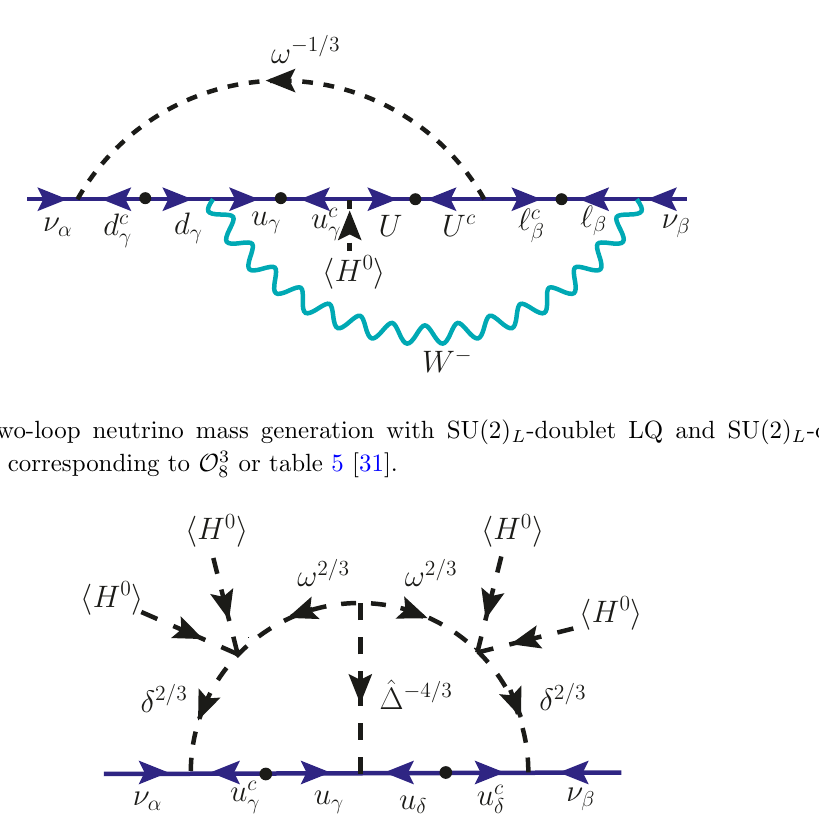
Figure 51 . New two-loop scalar LQ model with up-quark loops. The operator induced in the model is in eq. O d =13